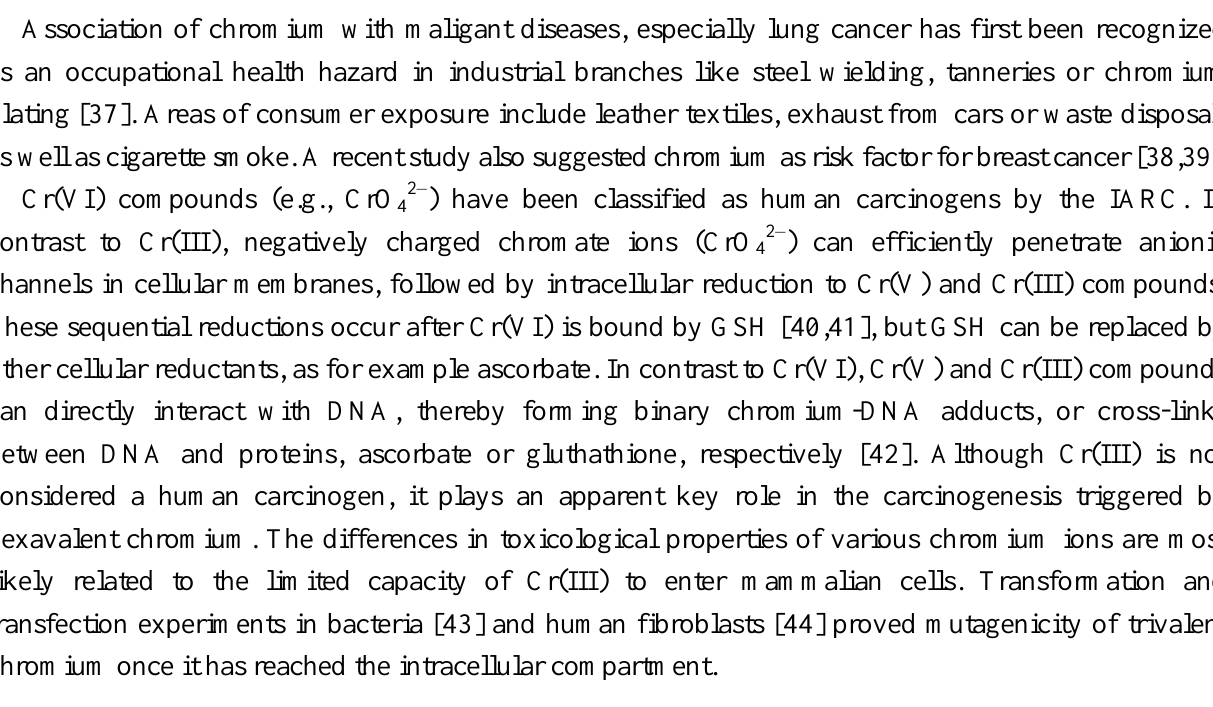
Figure 2. Carcinogenic mechanisms of chromium compounds. Chromium (VI) compounds are internalized in cells via anionic channels. Cr(VI) is then reduced and accumulates as trivalent ion. Formation of Cr(III)-DNA adducts is regarded as predominant carcinogenic mechanism (see text for details). In parallel, chromium ions can engage in Fenton-like reactions, generating hydroxy radicals. However, molecular details of these reactions need still to be clarified. The overall relevance of oxidative stress for chromium mediated carcinogenesis remains